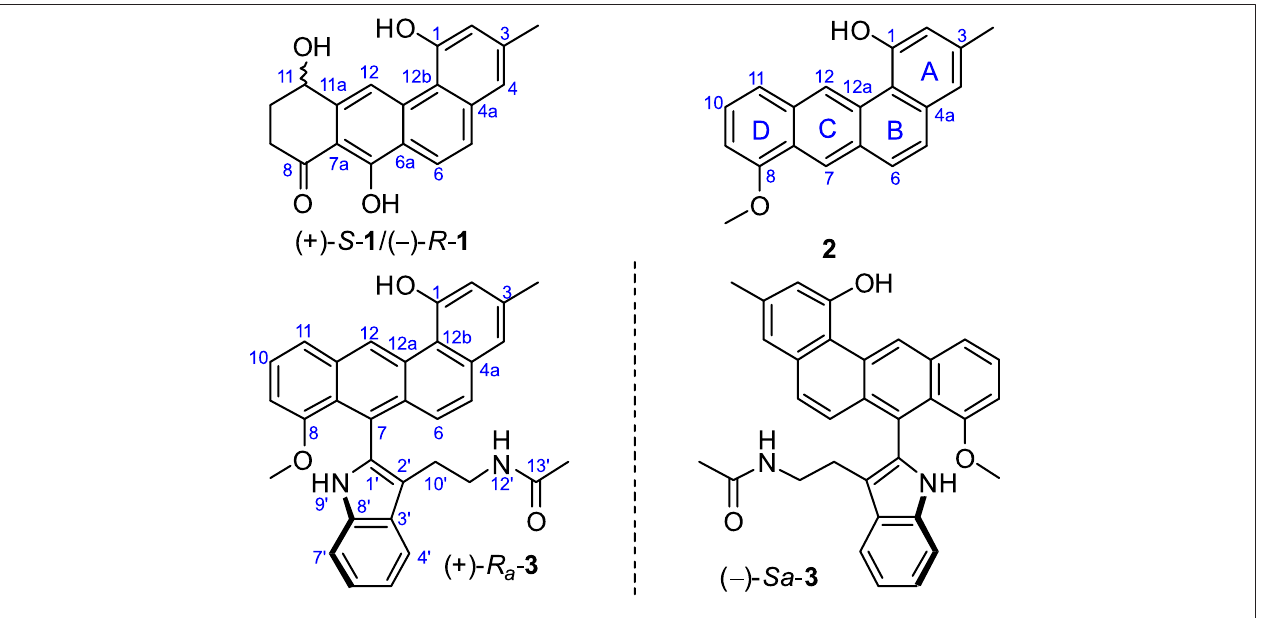
FIGURE 1 | Chemical structures of compounds 1 ‒